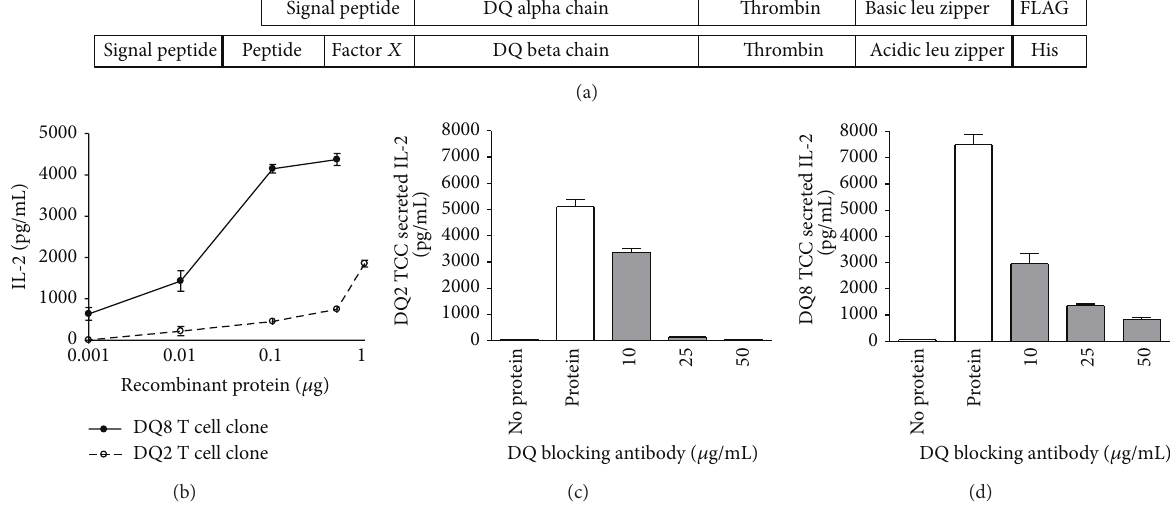
varying concentrations for blocking experiments. All study subjects had cytokine stimulation assays